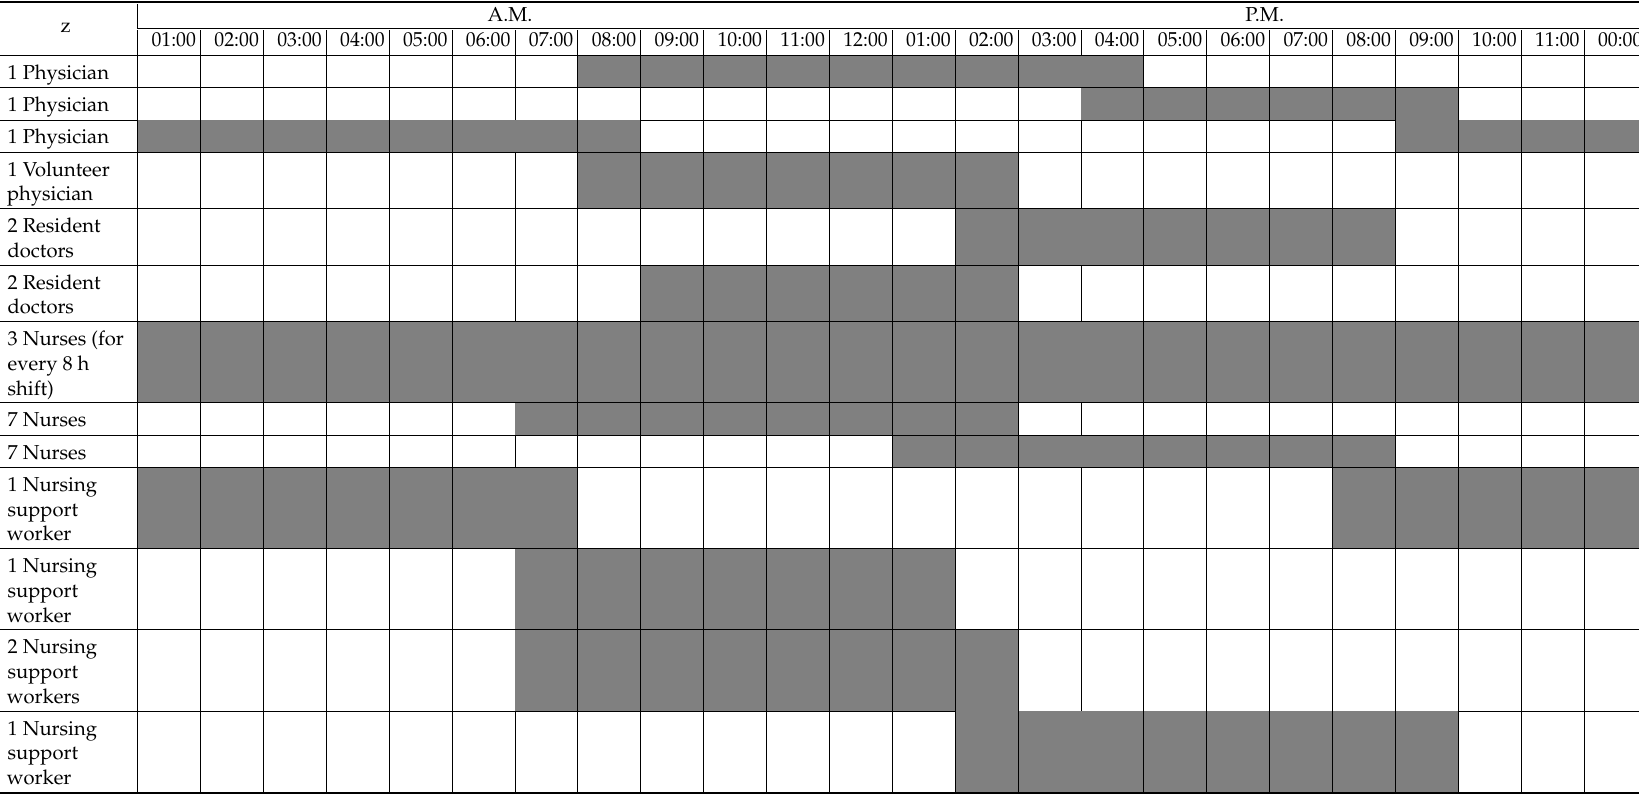
Table 1. Day working shifts for healthcare workers of the Advanced Triage of the Infectious Diseases